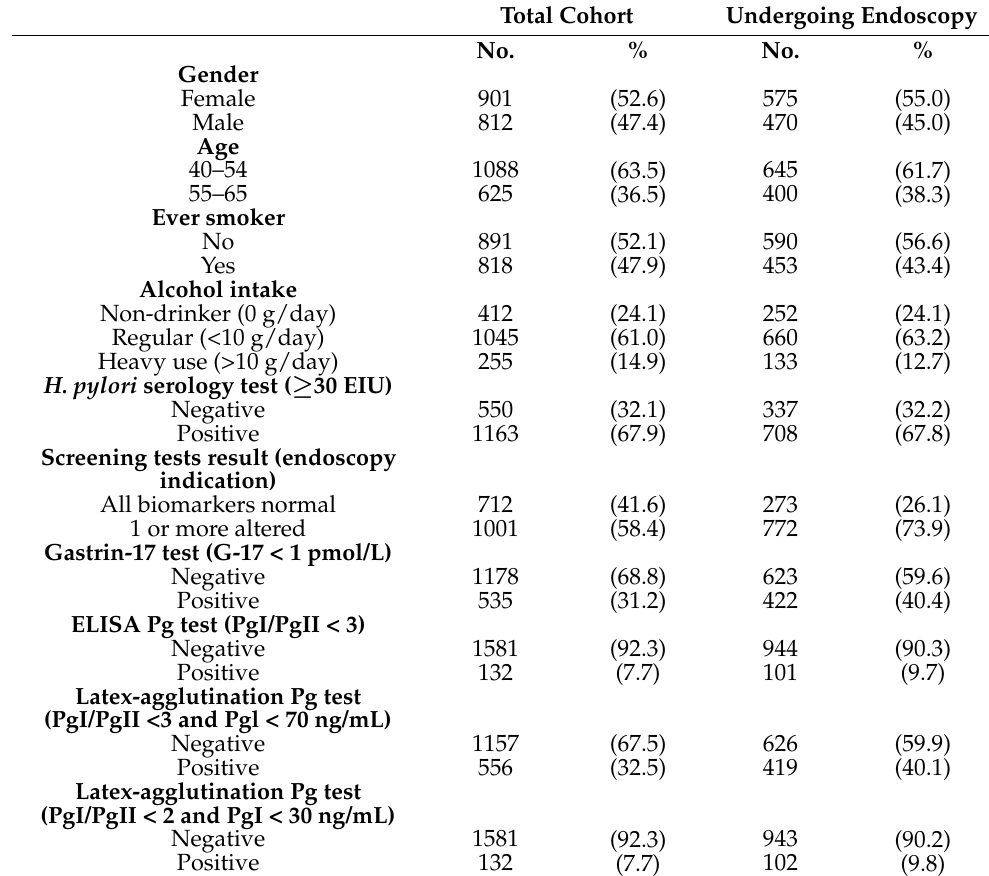
Table 1. Description of study participants; total cohort with valid screening results and those that underwent upper